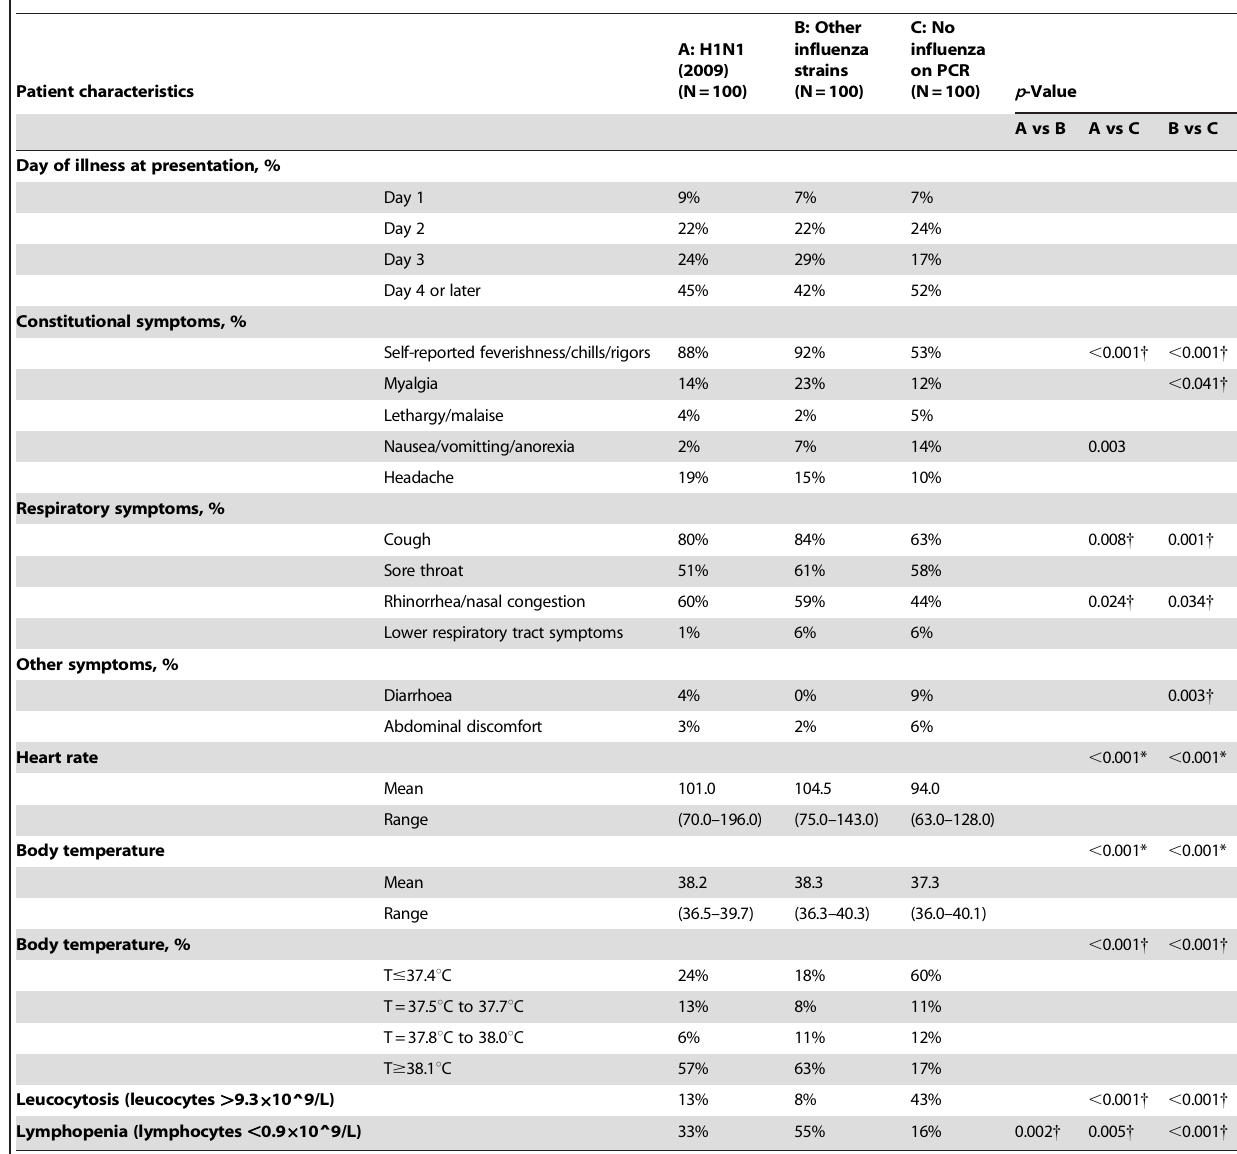
Table 2. Symptoms, clinical, laboratory, and radiological findings at